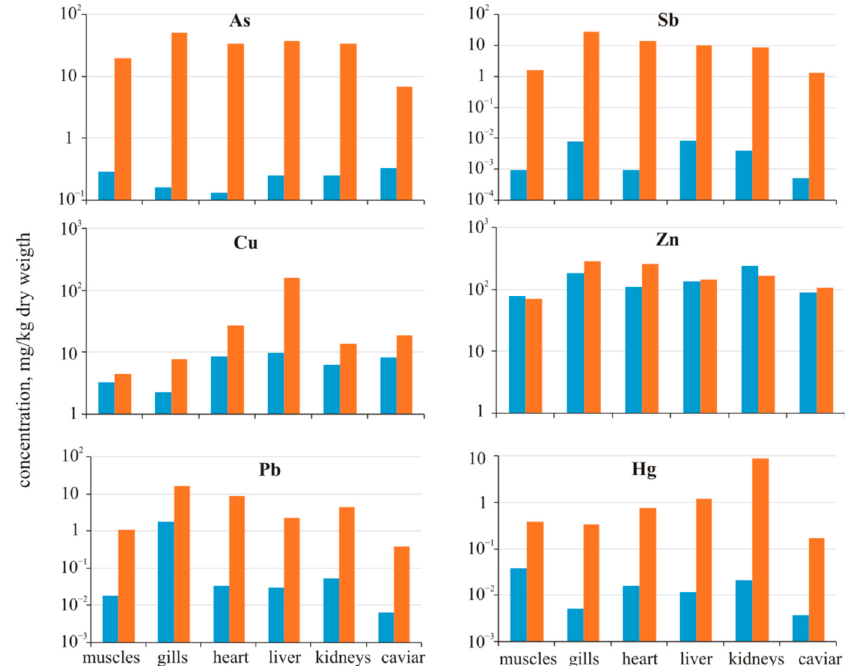
Figure 6. Comparison of element concentrations in organs of Carassius gibelio from Chany Lake (blue columns) and Komsomolsk pond (orange